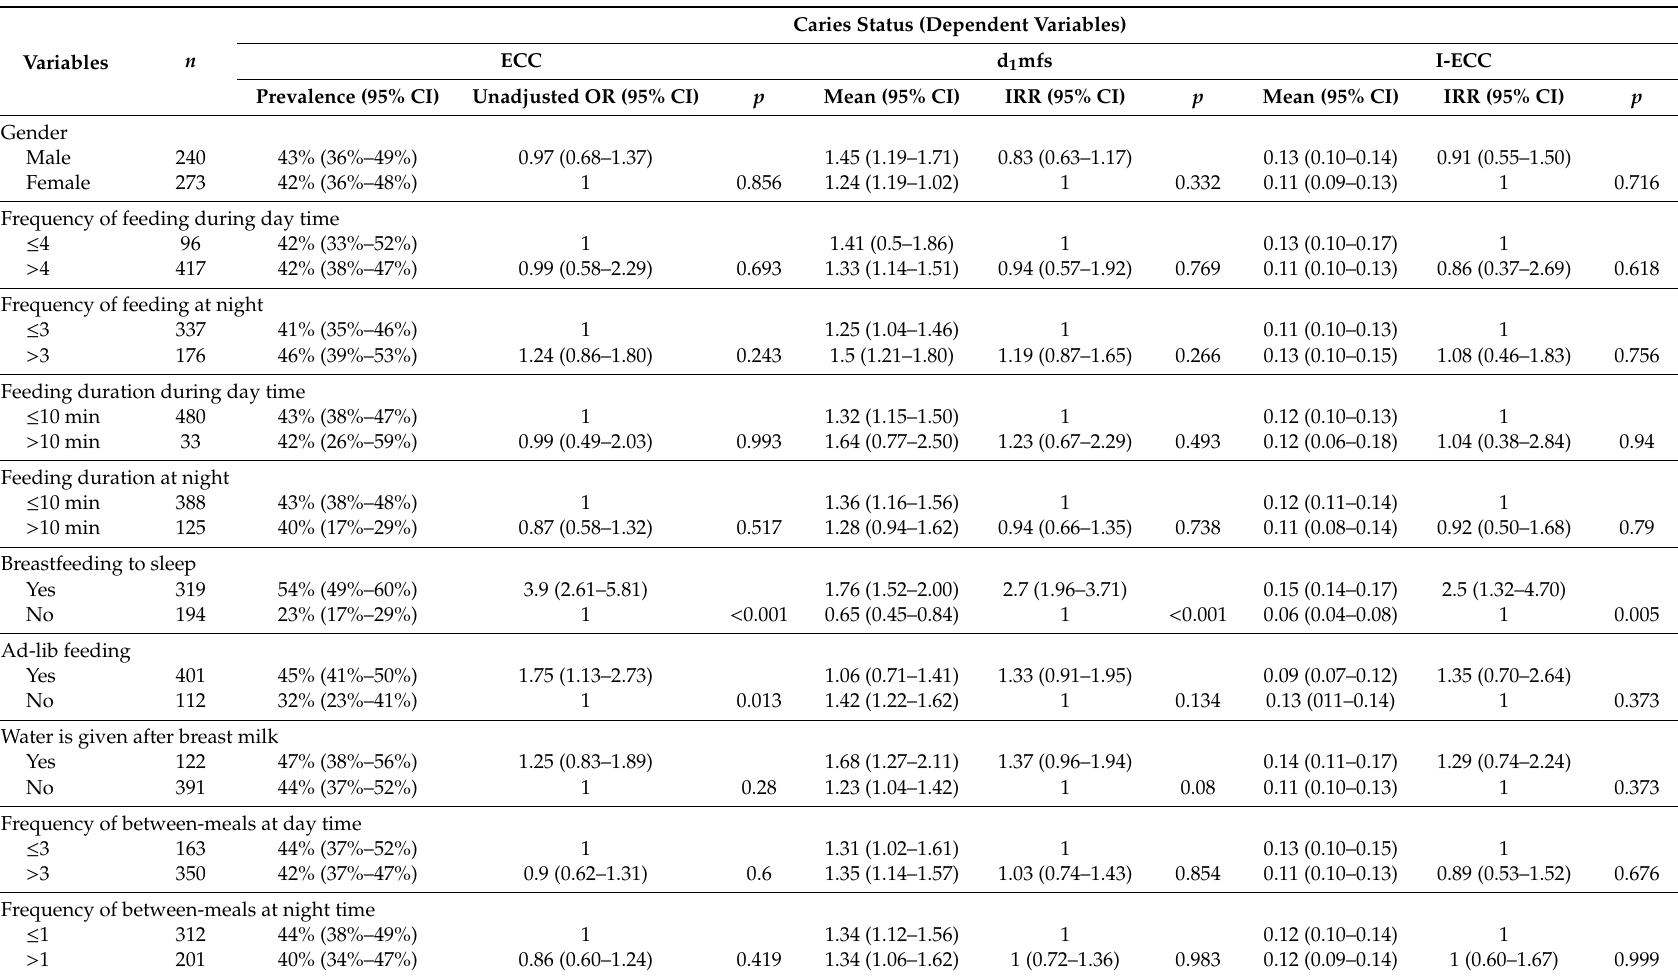
Table 3. Bivariate analysis of potential variables related to the prevalence of ECC, the mean of d 1 mfs score, and